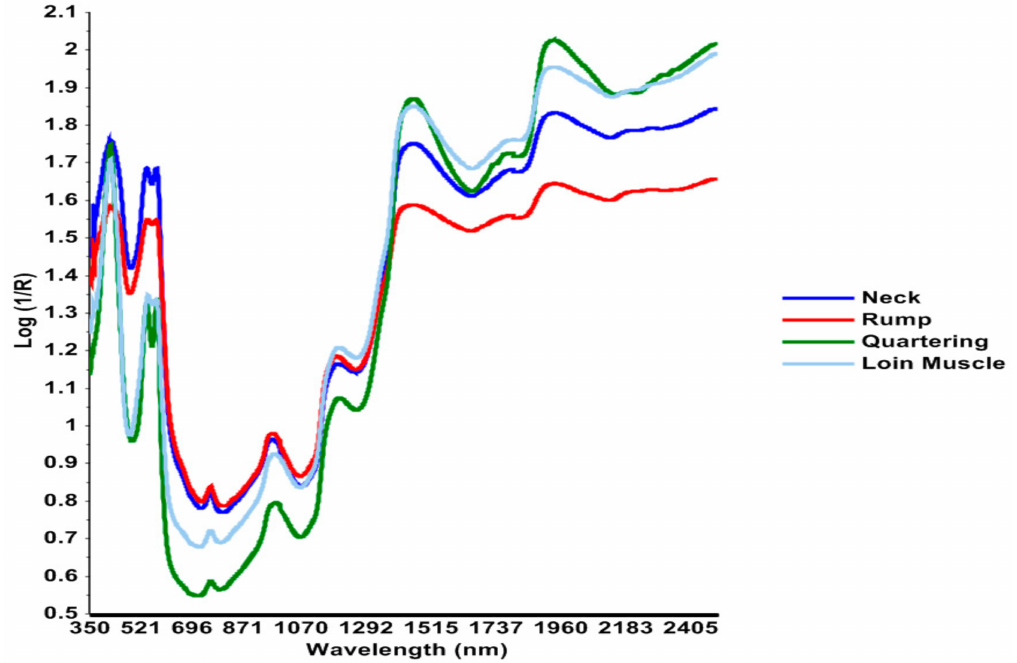
Figure 1. Average visible–near-infrared (Vis–NIR) spectra measured from neck and rump (1 h post-mortem), on quartering from the musculus longissimus thoracis et lumborum (LTL) muscle (24 h post-mortem) and from the loin muscle (48 h